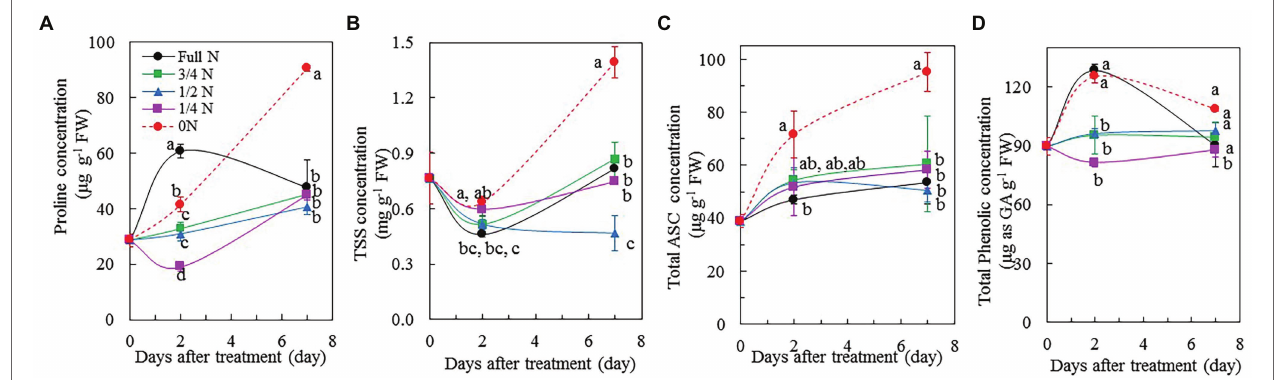
FIGURE 7 | Changes of proline (A) , total soluble sugars (TSS; B ), total ascorbic acid (ASC; C ), and total phenolic compounds (D) concentration in the leaves of M. crystallinum after different NO 3– treatments. Vertical bars represent the SEs. Means with different letters are statistically different ( p = 0.05; n = 4 for A,C,D ; n = 5 for B ) as determined by LSD multiple comparison